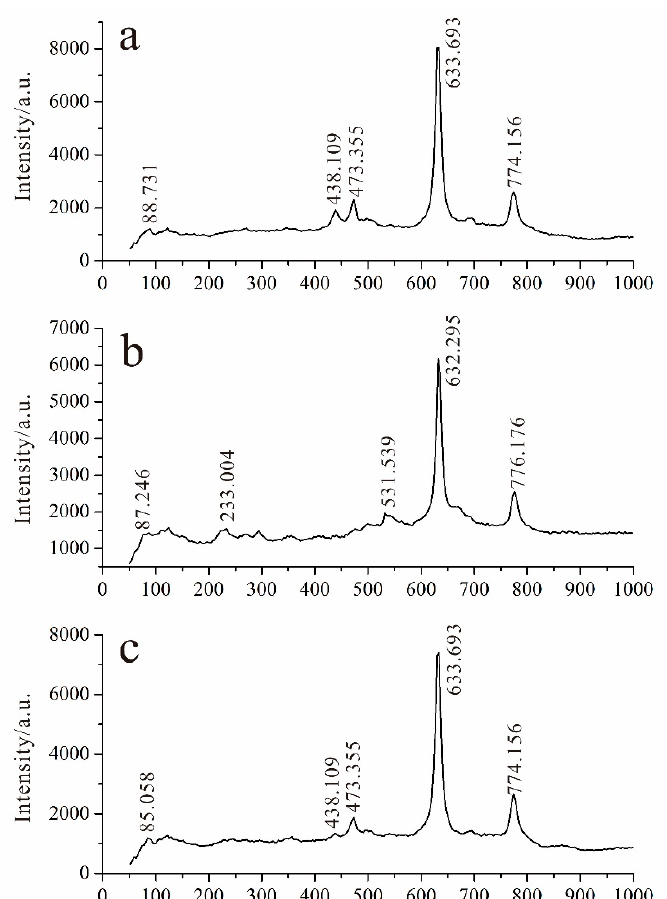
Figure 6. Measured Raman spectra of di ff erent cassiterite samples. ( a ) is XA-3, ( b ) is XA-4, ( c ) is XA-5.